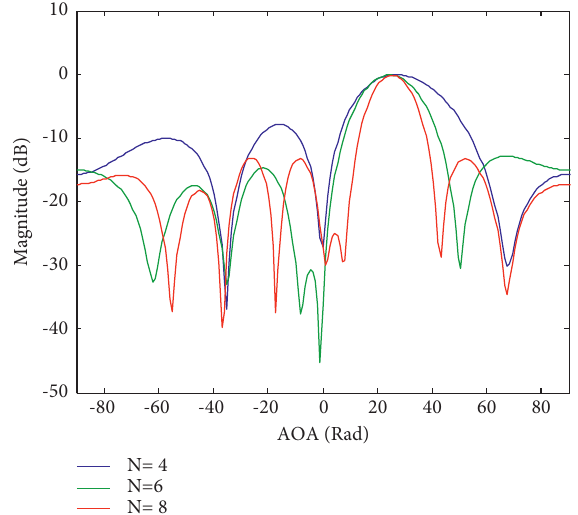
Figure 4: Effect of number of elements N on radiation (CM).